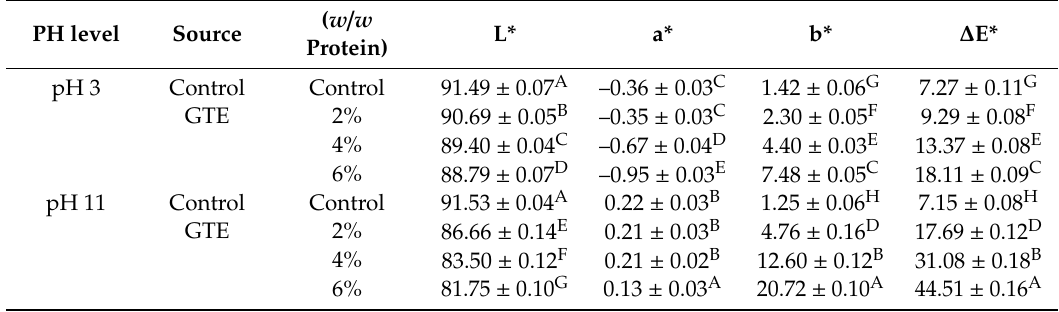
Table 4. The color determination of surimi-based edible films incorporated with di ff erent concentrations of GTE at pH 3 or pH